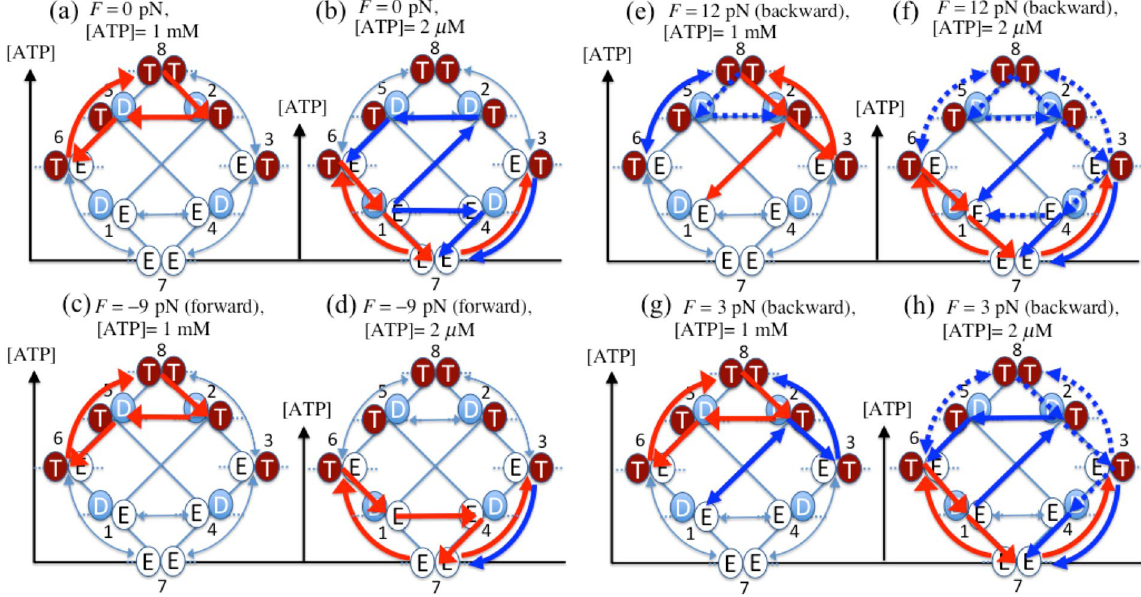
Figure 6. Diagram of main local fluxes corresponding to high (1 mM) and low (2 μ M) ATP concentrations ( a , b ) without a load and ( c , d ) with an assisting (forward) force of 9 pN and backward loads of ( e ), ( f ) 12 pN and ( g ), ( h ) 3 pN. The red arrows indicate normalized local fluxes larger than 0.10, while the blue arrows indicate the other normalized local fluxes larger than 0.02, where the normalized local flux is the local flux divided by the sum of all of the local fluxes. The dashed blue arrows indicate normalized local fluxes less than 0.02 but are directly related to the mechanical transitions. Bidirectional arrows signify that the absolute values of both of the local fluxes are almost the same so that the excess flux is about